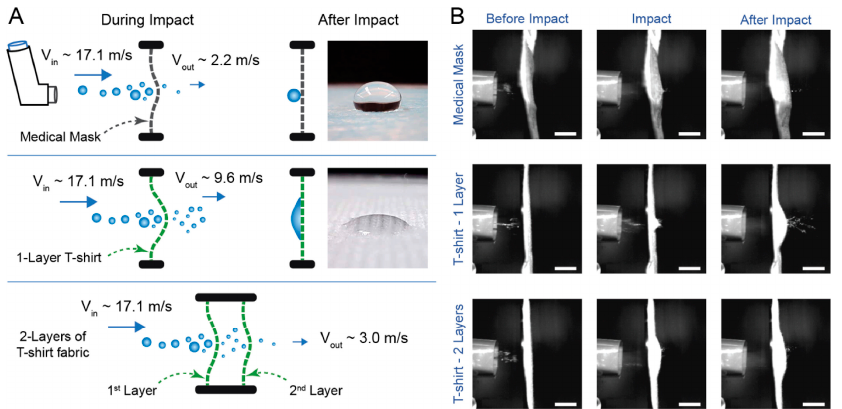
Figure 2. Comparative performance analysis between medical masks and knitted sample against high-impact droplets. ( A ) Schematic presentation of the impact of a high-speed droplet on the medical mask and knitted sample. ( B ) Impact response on medical masks and knitted samples [19]. Neupane and colleagues also reported a loss of filtration efficiency due to repeated washing and drying of reusable knitted face coverings. These cycles increased the fabric void sizes and morphed their shapes (Figure 3) [54]. Other sources warn against the use of stretchy materials because of the tendency for voids to increase in size [13,55].